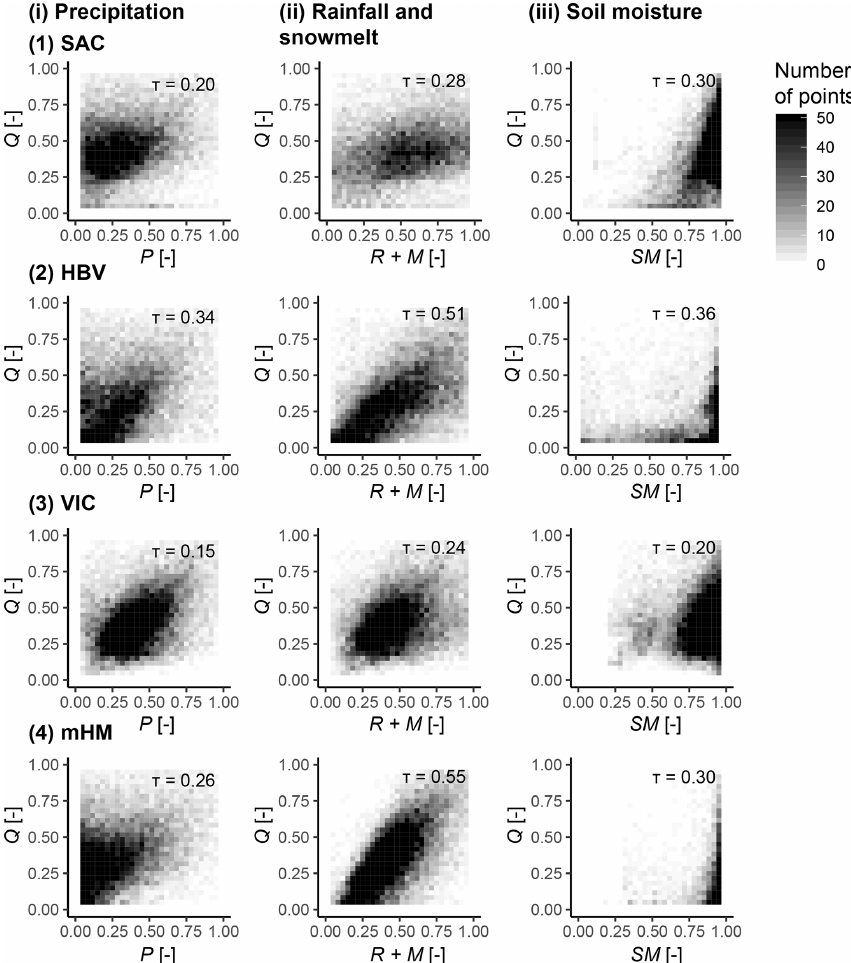
Figure 5. Simulated relationships between normalized flood discharge ( Q ) and normalized precipitation (i; P ), rainfall and snowmelt (ii; R + M ), and soil moisture (iii; SM , upper two soil layers for mHM) over all catchments represented by a binned scatter plot for the four hydrologic models (1) SAC, (2) HBV, (3) VIC, and (4) mHM. The darker the color, the higher the number of points within a bin (one point per catchment and event). Kendall’s correlation coefficients are provided in the upper right corners of the